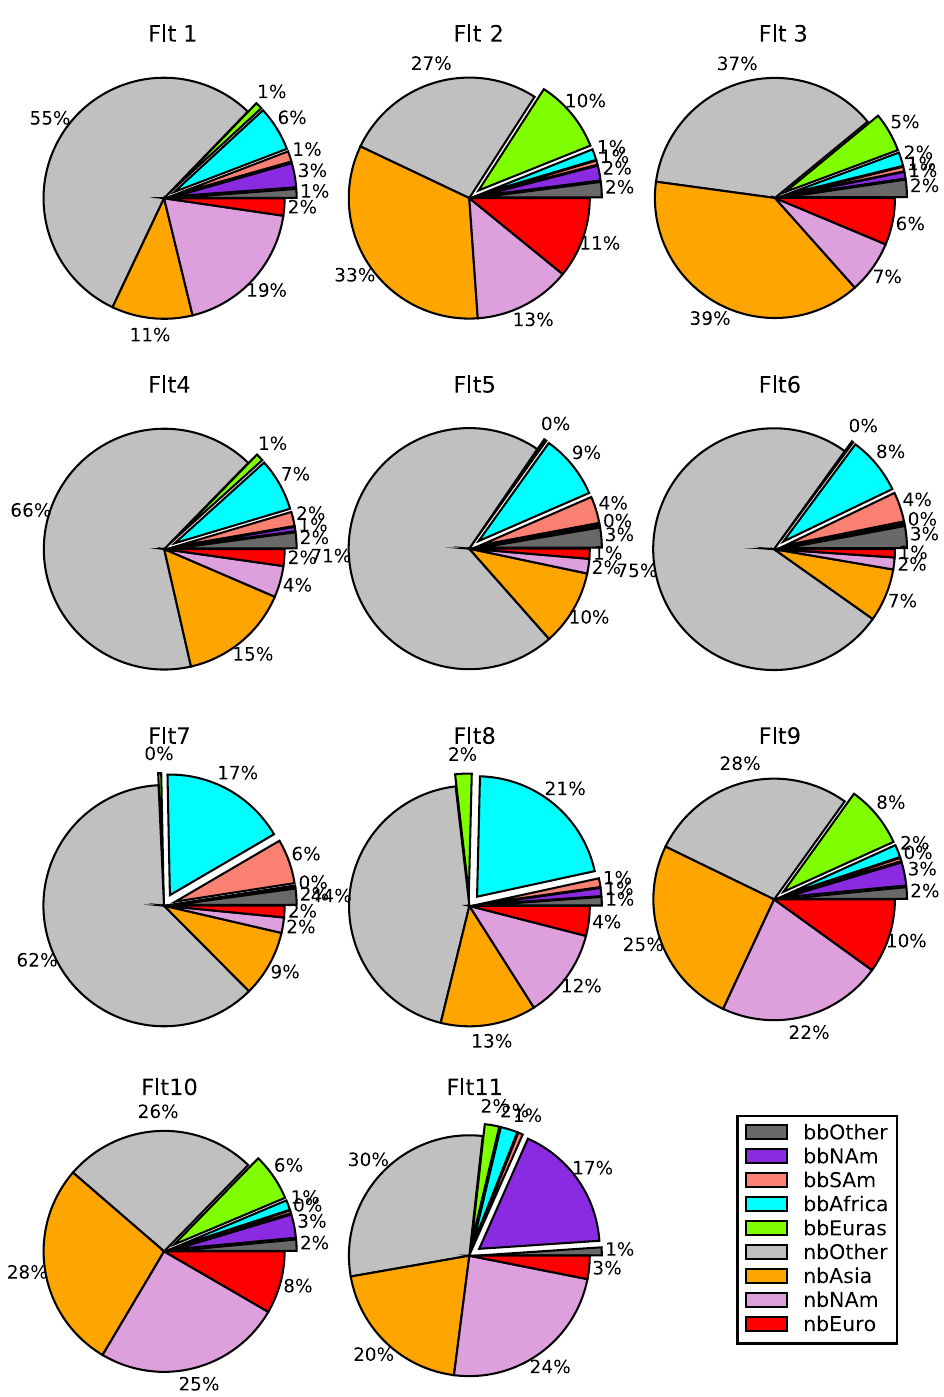
Figure 7. Percent contributions of tagged tracers to total CO for each flight. Exploded slices represent the biomass burning (bb) tracers: North American (purple), S. American (salmon), African (cyan), Eurasian (green), and other (dark gray). The non-biomass-burning (nb) tracers are for Asia (orange), N. America (lavender), Europe (red), and other (light